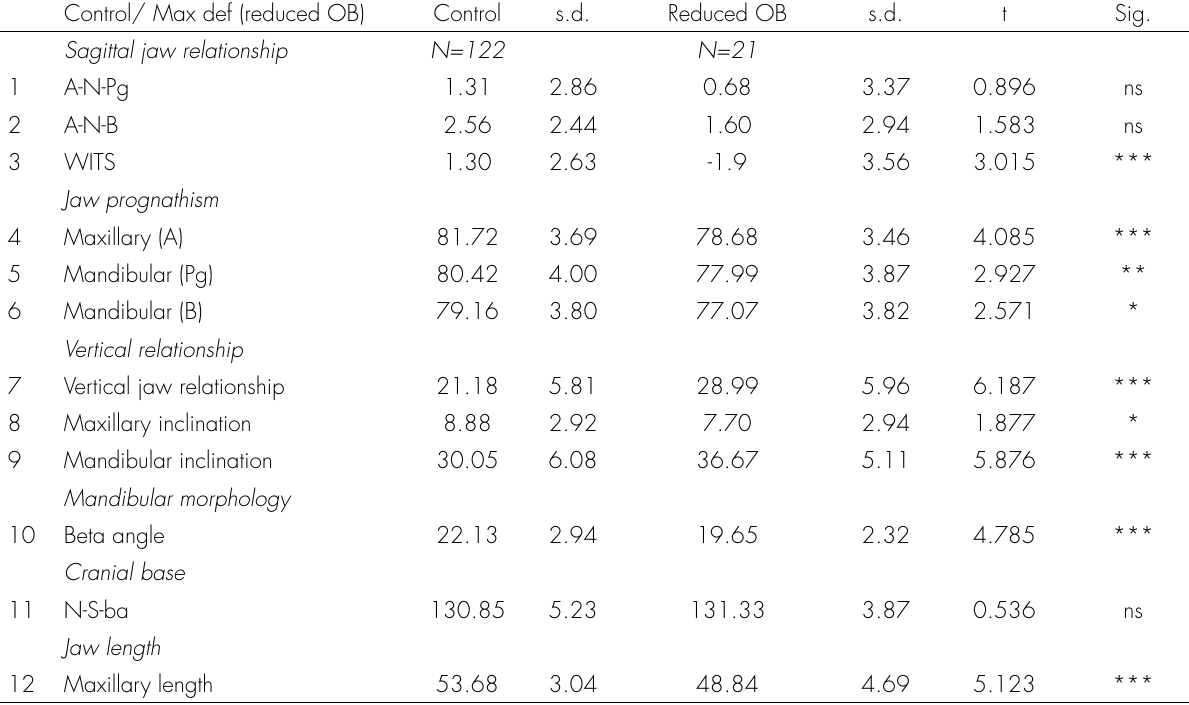
Table IIIh. Comparison between groups of the experimental material and the control material in terms of exhibiting a reduced vertical overbite in the incisor